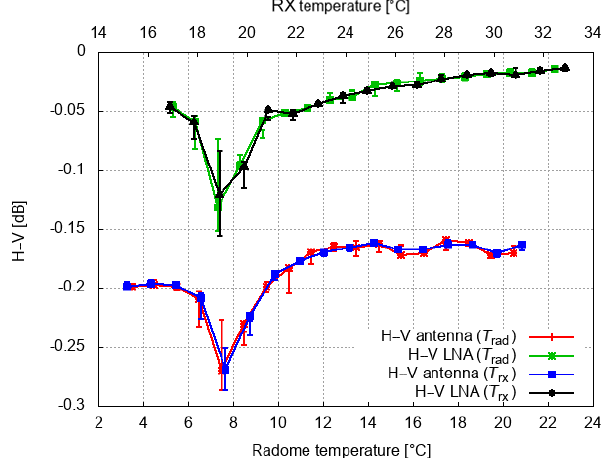
Figure 18. Radar-network-wide-calibrated Z DR using birdbath data. Also shown is the median Z DR over a 5d interval from Jan- uary 2013 until September 2018. There is no systematic annual vari- ation in Z DR , which implies that it is not necessary to distinguish the precipitation phase when calculating the Z DR from birdbath data.